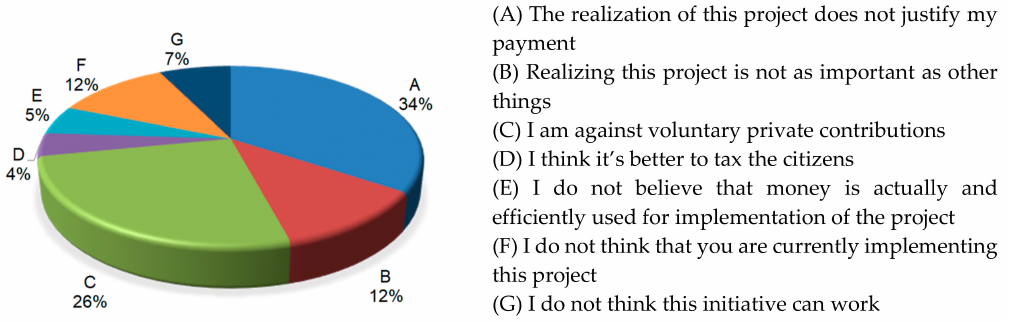
Figure 7. Reasons for opposition to the project (real